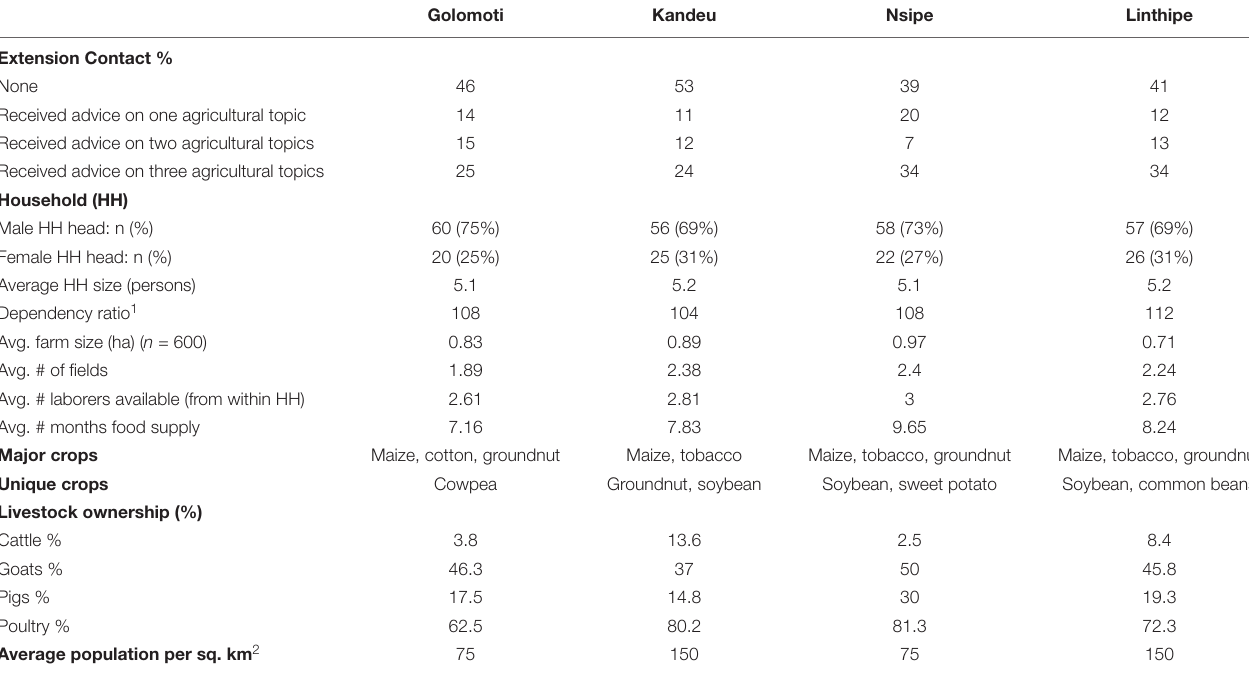
TABLE 2 | Social characteristics for farmers in the four sites in Central Malawi based on surveys ( n = 324 except where otherwise noted) conducted in July of 2013. Golomoti Kandeu